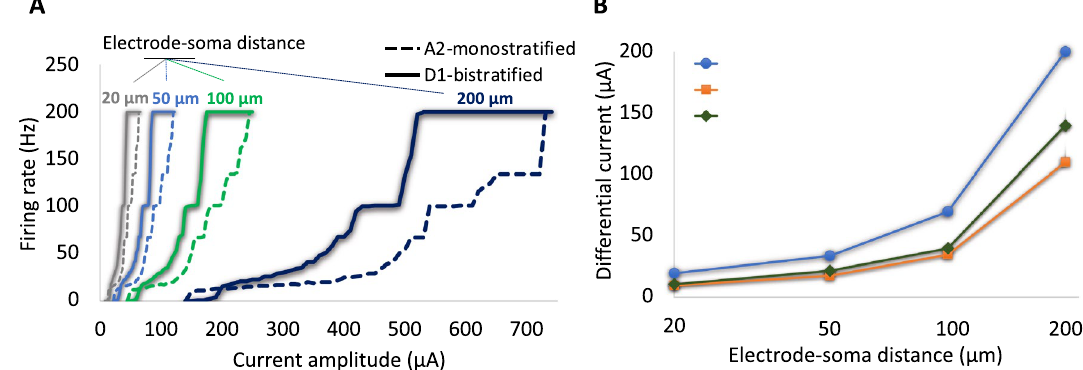
Figure 8. The influence of electrode-cell distance on response and selective activation of RGCs at 200 Hz. ( A ) Firing rates of the A2 and D1 RGCs as a function of current amplitude for four difference electrode-soma distances (20 µm, 50 µm, 100 µm, and 200 µm). ( B ) Current amplitude difference between the two cells required to obtain firing rates (FRs) of 20 Hz, 100 Hz, and 200 Hz with increase in the electrode-soma distance. Data show that the differential firing rate and current amplitude of RGCs increased with increasing electrode-cell distance, suggesting the enhanced chance for preferential activation of D1